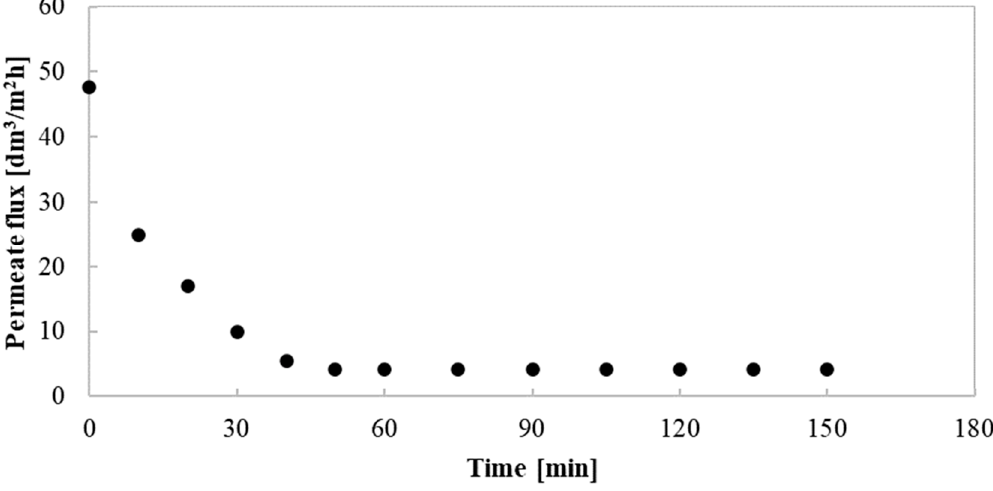
Figure 3. Changes of permeate flux during the UF process under TMP = 0.1 MPa and Q = 200 dm 3 /